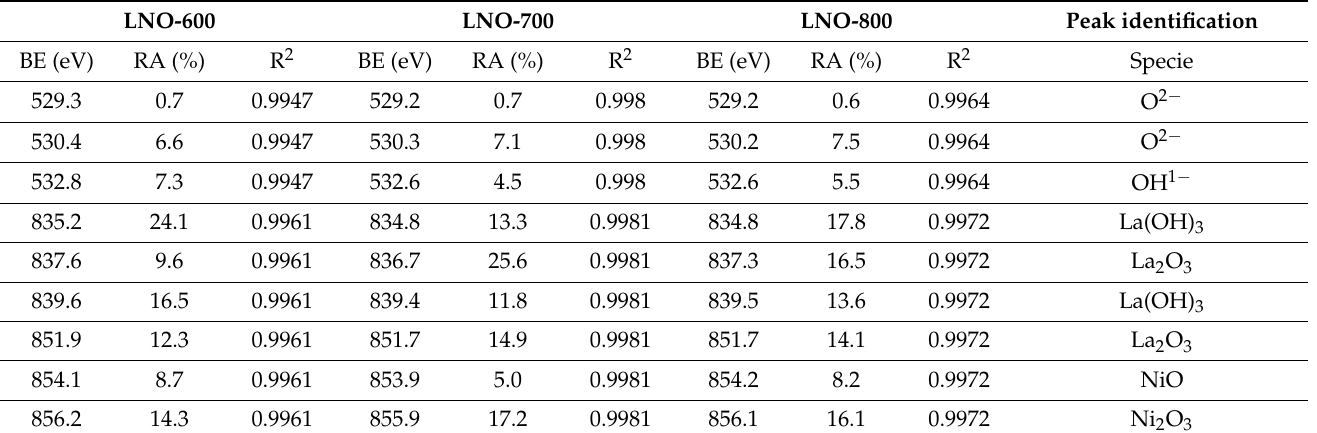
Figure 7. XPS spectra and deconvolution analysis of La(3d) and Ni(2p) signals of LNO-600 ( A ), LNO- 700 ( B ) and LNO- 800 ( C ), as well as the O (1s) signal of LNO-600 ( D ), LNO-700 ( E ), and LNO-800 ( F ). Table 1. XPS fitting binding energy (BE) values and relative area (RA) results obtained from the LaNiO 3 samples calcined at different temperatures.